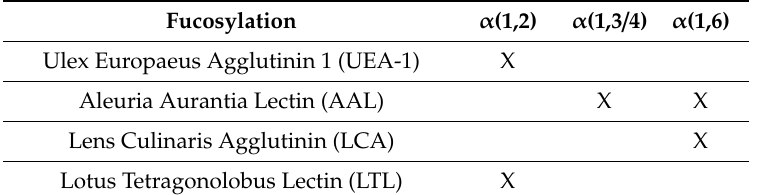
Table 1. Lectins commonly used in for the detection of specific branches of fucosylation.